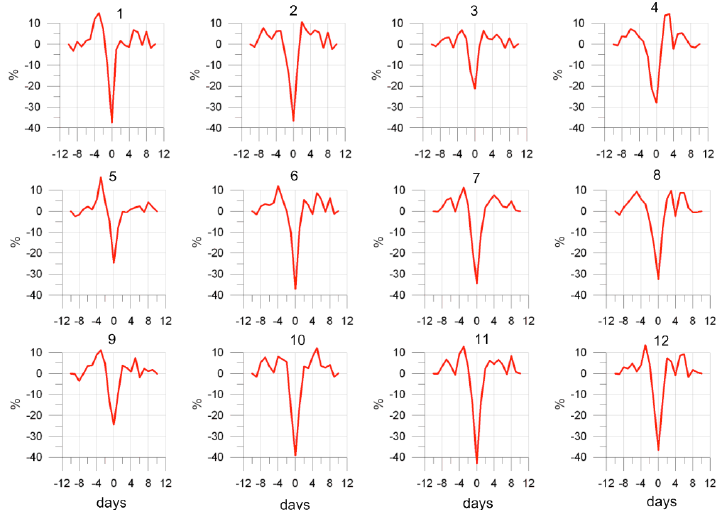
Figure 6. Cross-covariance function for the signal recorded onboard the DEMETER satellite in the frequency range 150–500Hz averaged in the zones of analysis and Dst indexes. Y axis is the correlation coefficient.